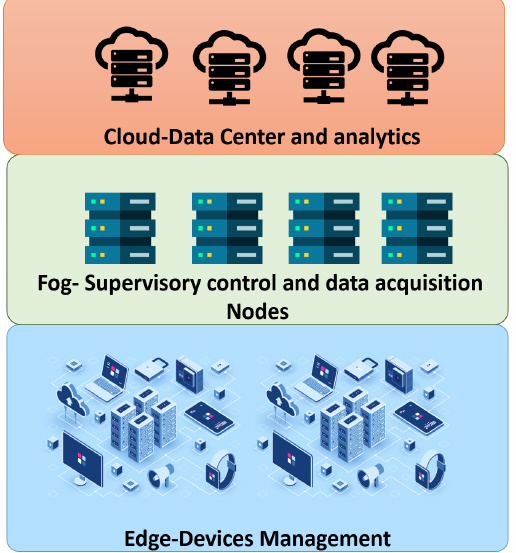
Figure 10. Predictive maintenance analytics from the edge to cloud.